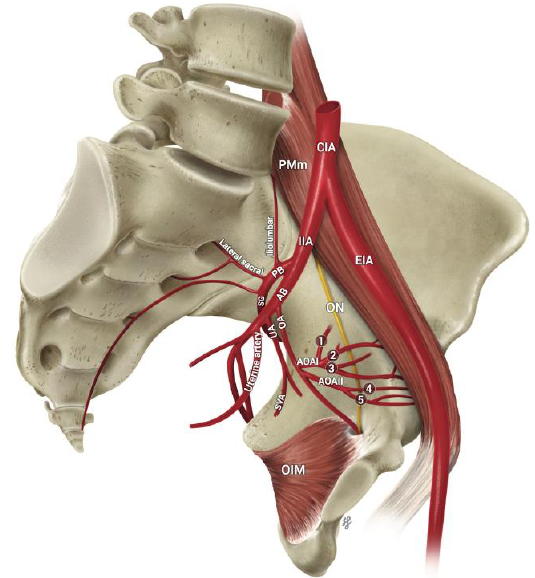
Figure 1. Illustration showing the atypical findings in the pelvic region presented in the case report. The common iliac artery (CIA) passes through the psoas major muscle (PMm) and divides into the external iliac artery (EIA) and internal iliac artery (IIA). The artery travels along the obturator fascia of the obturator internus muscle (OIM) of the pelvic sidewall, between the obturator nerve (ON) and obturator vein. A variation was found with multiple branches in its course before leaving the pelvic cavity through the obturator foramen. The anterior branch (AB) of the internal iliac artery (IIA) provided the obturator artery (OA) branch, divided into two atypical OA-provided anatomically variant branches. Abnormal obturator artery I (AOAI) gave rise to three branches (1, 2, 3), while abnormal obturator artery II (AOAII) gave rise to two branches (4, 5). In addition, anterior branches (AB) such as the umbilical artery (UA), superior vesical artery (SVA), uterine artery and other branches from the posterior branch (PB), superior gluteal artery (SG), lateral sacral artery, and iliolumbar artery were anatomically oriented.